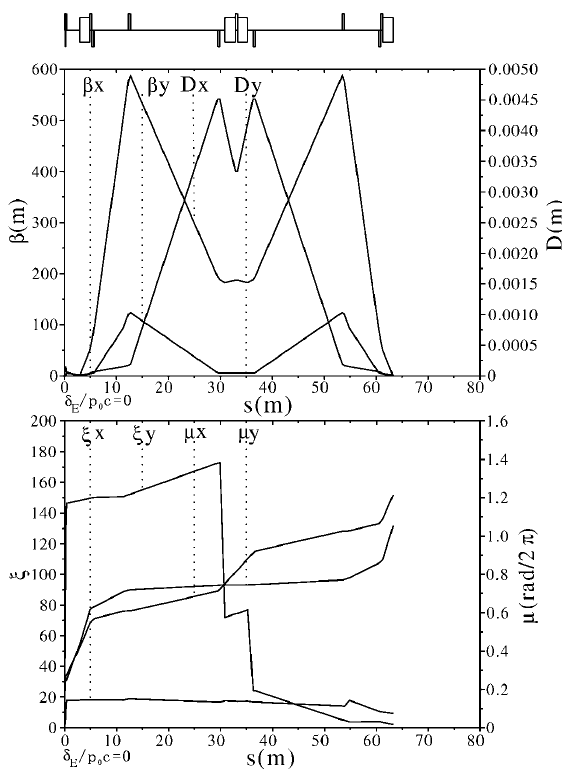
FIG. 11. The defocusing optics with chromaticity correction for laser-Compton cooling.